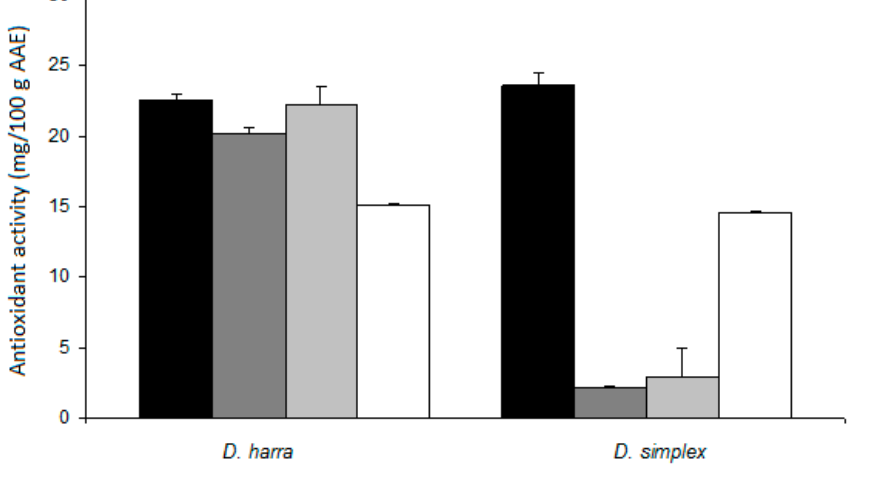
Figure 1. Concentration of flavonols and flavones before and after contact with artificial saliva , gastric and intestinal fluid .